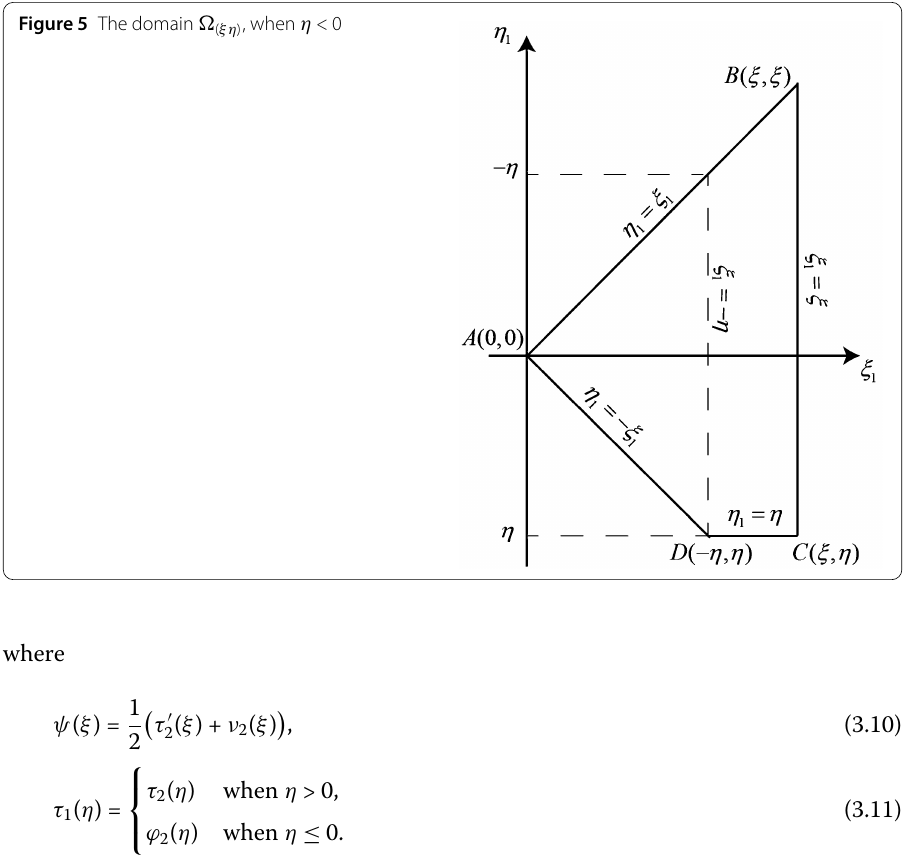
Figure 5 The domain (cid:10) ( ξη ) , when η <